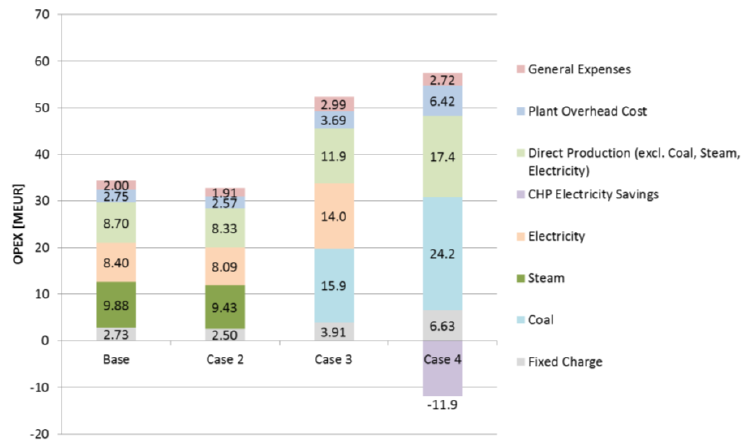
Figure A4. OPEX for carbon capture in cement plants.